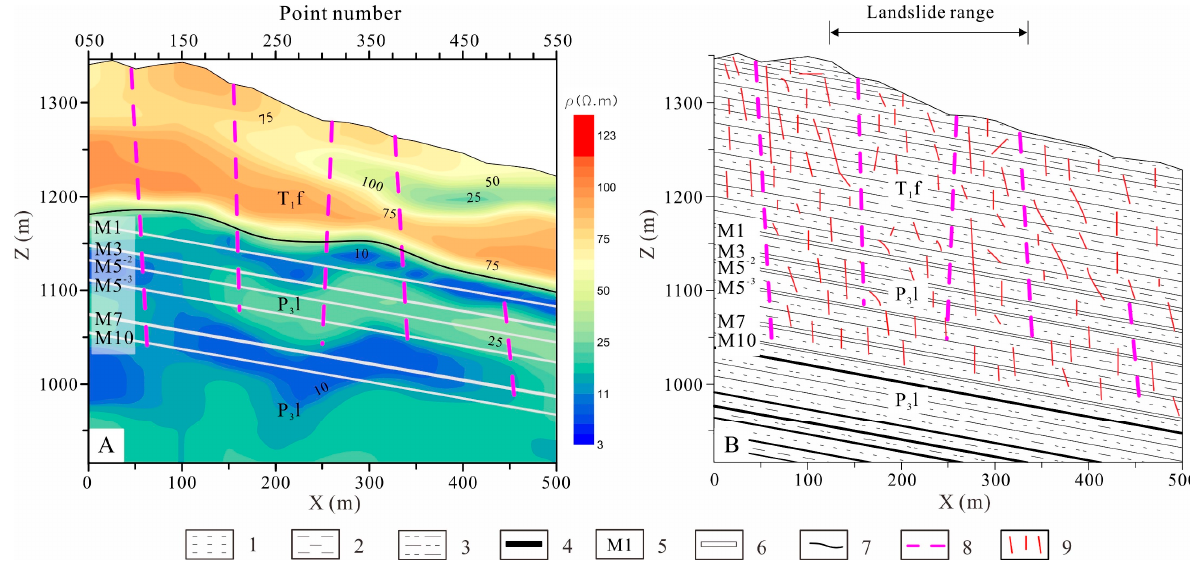
Figure 15. Surface transient electromagnetic inversion map of survey line III − III ′ : ( A ) section isoline of the apparent resistivity; and ( B ) geological section. (The legend meanings are shown in Figure 14).